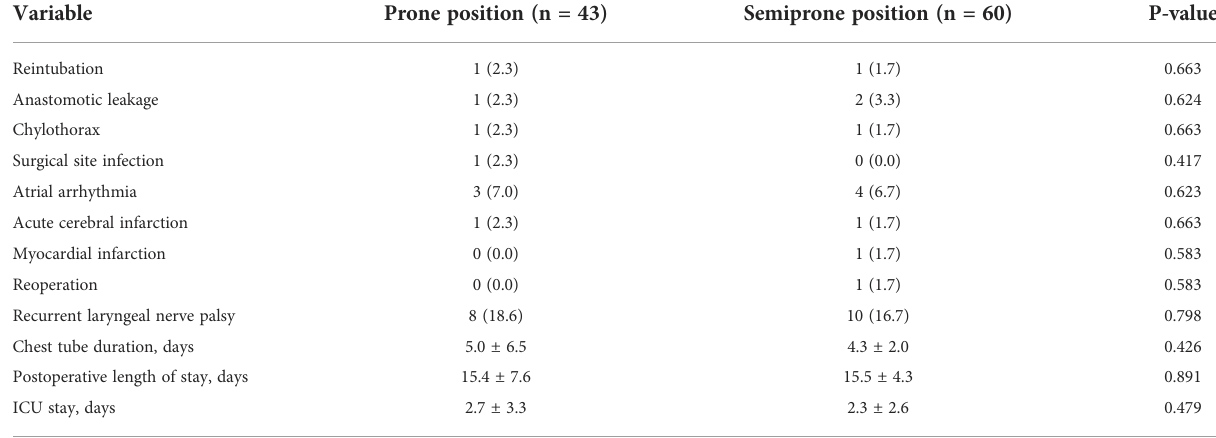
TABLE 4 The other postoperative complications between the prone position and semiprone position. Variable Prone position (n = 43) Reintubation